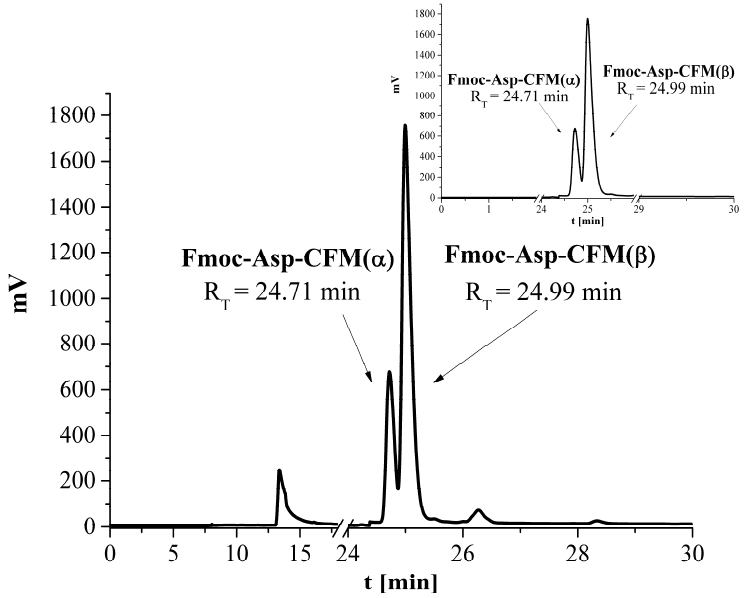
Figure 2. HPLC chromatogram (at 270 nm) of the reaction mixture of Fmoc-Asp-CFM derivative synthesis (products of step 2: isomer α (R T = 24.71 min) and isomer β (R T = 24.99 min) (gradient 2).